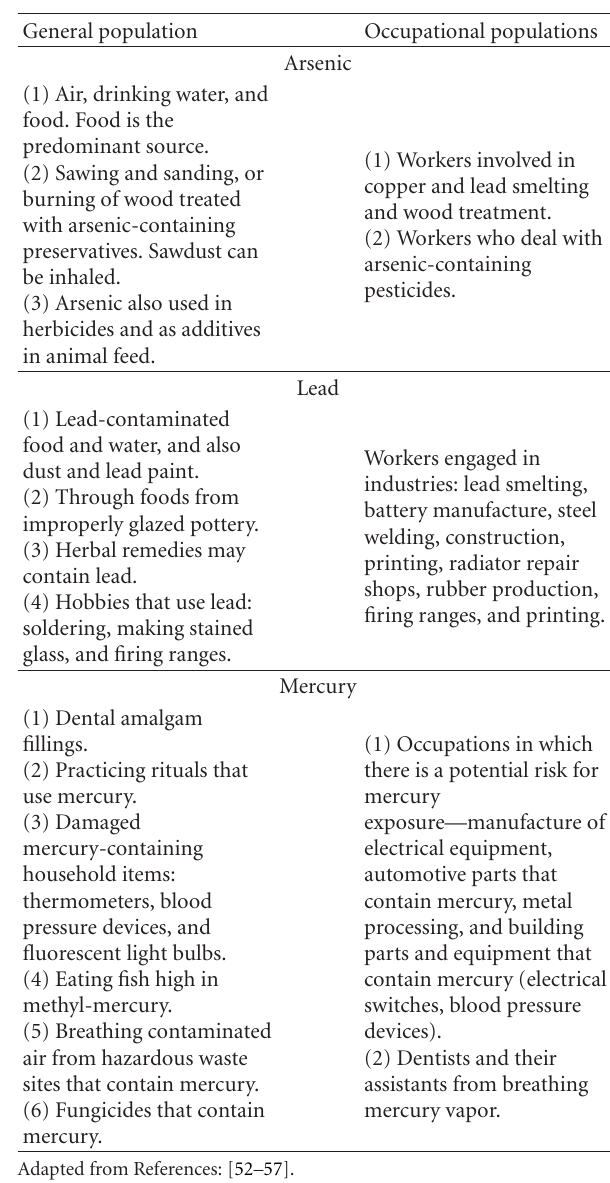
Table 1: Sources of exposure to arsenic, lead and